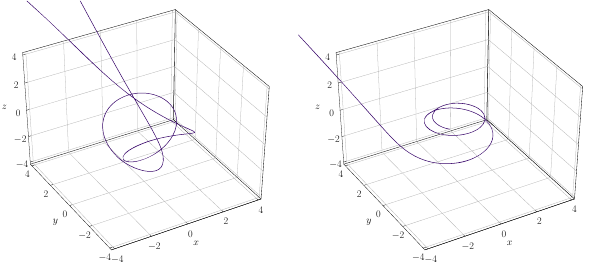
Fig. 3 Orbits around a Kerr black hole with spin parameter a = 0 . 98. Left panel: escape orbit; right panel: falling